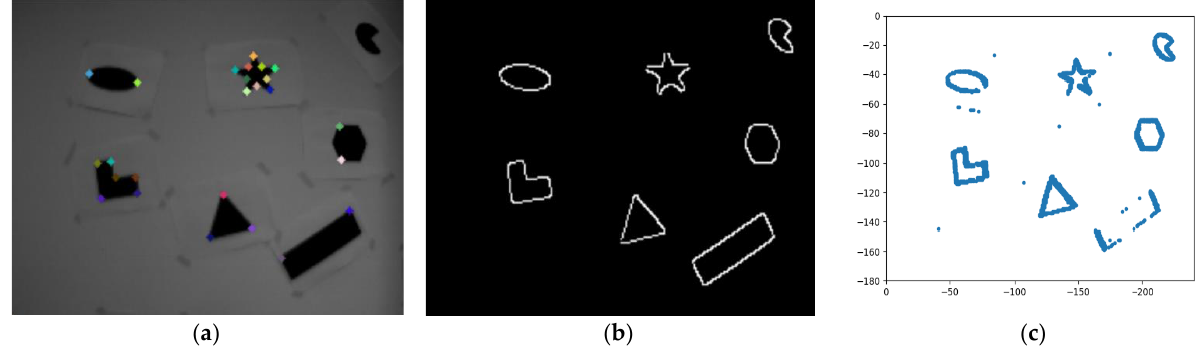
Figure 2. Detection of the tracking template. Using the feature points image in ( a ) and the edge points image in ( b ), we can obtain the tracking template. As shown in ( c ), we visualize the events of the first spatio-temporal window.